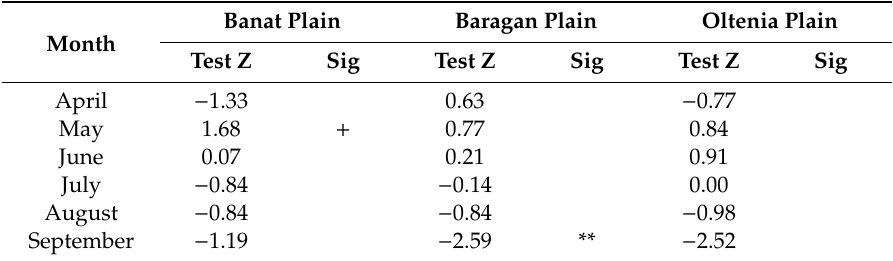
Table 5. SPEI trend according to the Mann-Kendall test (2001–2019).